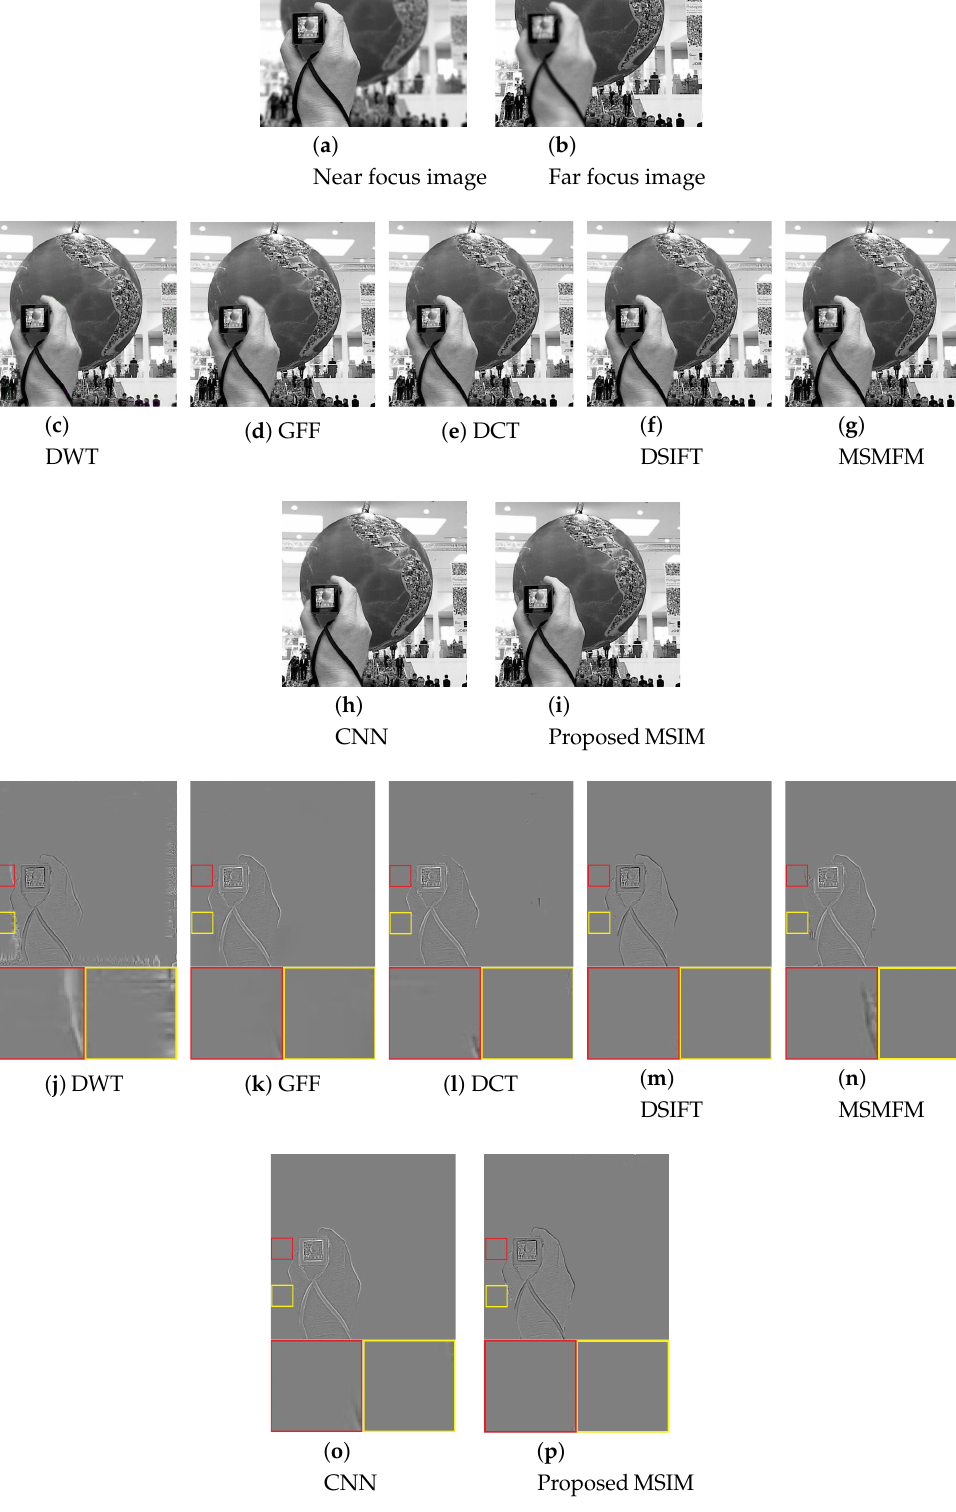
Figure 5. Results of image fusion and their difference images on the “Globe” source images. ( c – i ) Fused images obtained through fusion schemes. ( j – p ) Difference images obtained from the fusion results and Figure